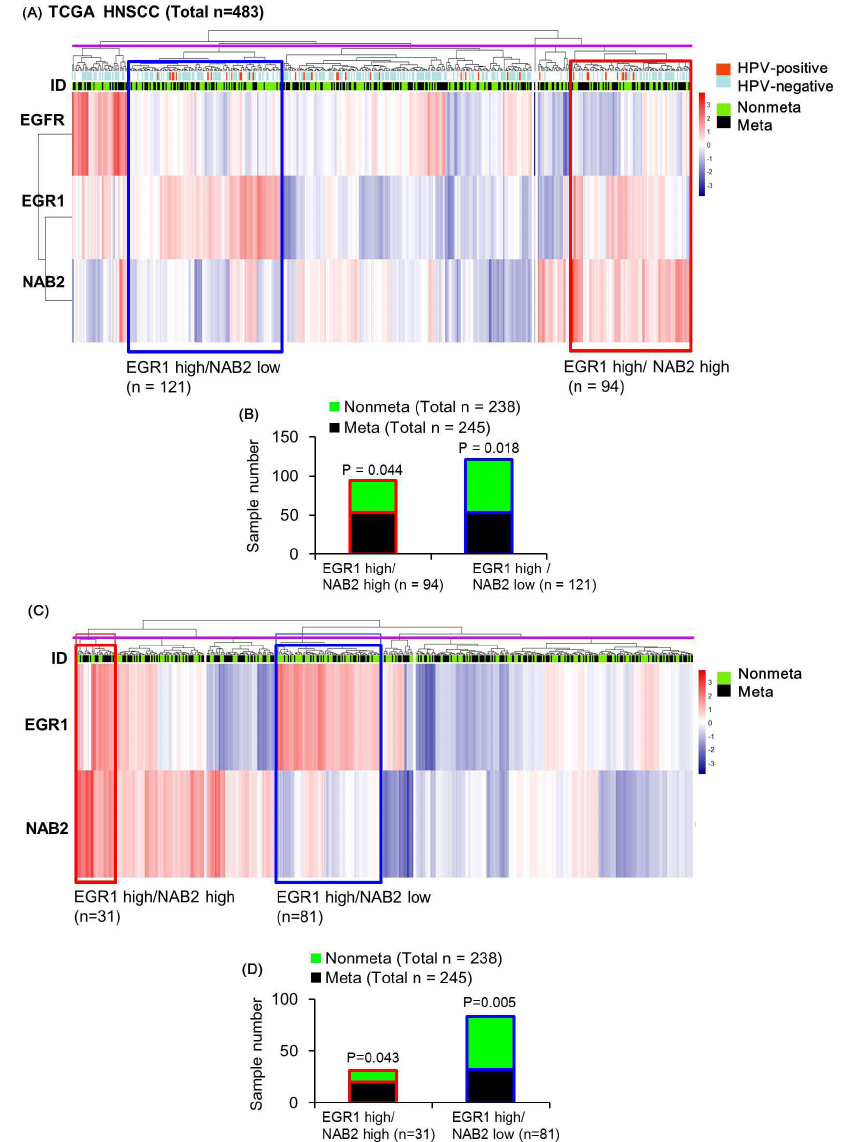
Figure 5. Heatmap representation of the relative mRNA expression levels of EGFR / EGR1 / NAB2 in the The Cancer Genome Atlas (TCGA) population of head and neck squamous cell carcinoma (HNSCC) specimens. Unsupervised hierarchical clustering with distance measured based on Pearson correlations was performed using log 2 -transformed FPKM-UQ normalized mRNA expression data for EGFR , EGR1 , and NAB2 for all patients. Tumors from metastatic and non-metastatic patients were annotated with green and black bars, respectively. ( A ) The subgroup indicated by a red box was found to display high EGR1 mRNA expression and high NAB2 mRNA expression. In contrast, the subgroup indicated by the blue box represents high EGR1 mRNA and low NAB2 mRNA expression. ( B ) The distribution of meta-nonmeta patients according to EGF / EGR1 / NAB2 expression in the heatmap is shown as a bar graph. ( C ) Heatmap representation of the relative mRNA expression levels of EGR1 / NAB2 according to human papilloma virus (HPV) infection in the TCGA population. The subgroup indicated by a red box was found to have high EGR1 mRNA expression and high NAB2 mRNA expression. In contrast, the blue box shows a subgroup with high EGR1 mRNA and low NAB2 mRNA expression. ( D ) The distribution of meta-nonmeta patients according to EGR1 / NAB2 expression in the heatmap is shown as a bar graph.